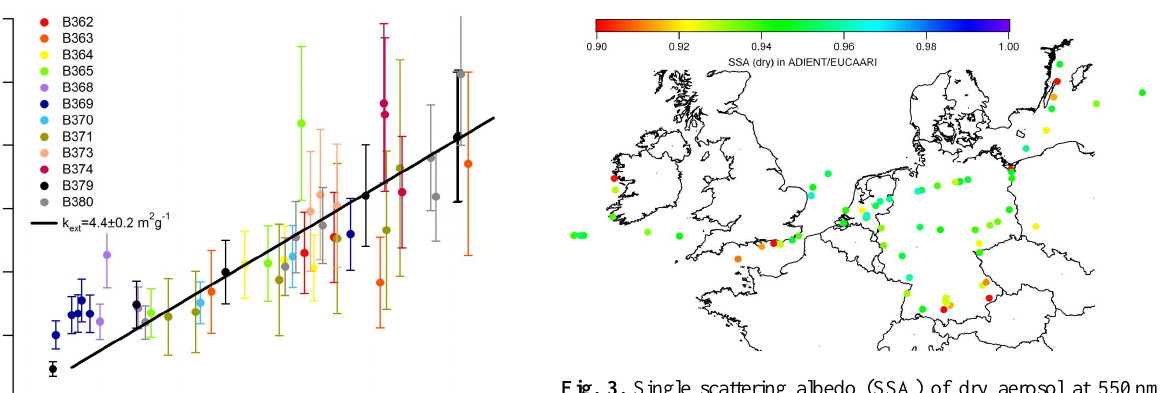
Fig. 3. Single scattering albedo (SSA) of dry aerosol at 550nm as derived from PSAP and nephelometer measurements on board the BAe146. Markers are positioned at the mid-points of the SLRs. Only SLRs below 2000m (i.e. within the average boundary layer) are included as the aerosol concentrations drop rapidly above the boundary layer leading to large uncertainties in the scattering and absorption measurements.